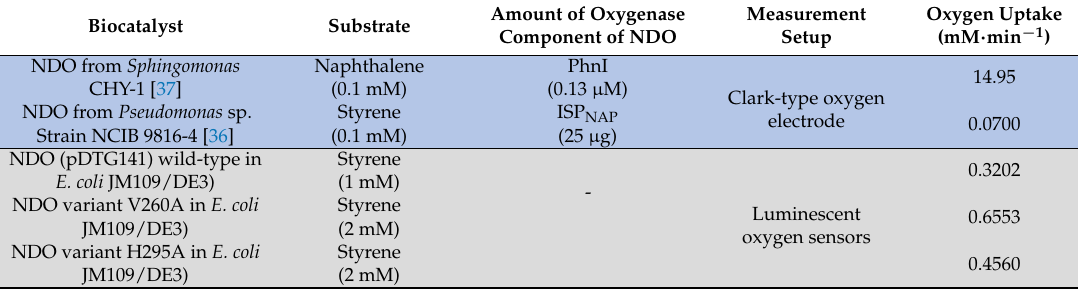
Table 1. Comparison of oxygen consumption rate/oxygen uptake of the whole cell catalyst (in grey) with values for pure dioxygenases found in literature (in blue)